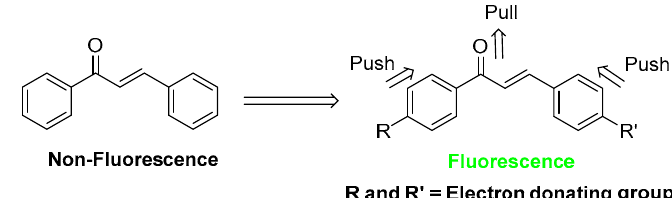
Figure 1. Structural design of chalcone-based fluorescent dyes.